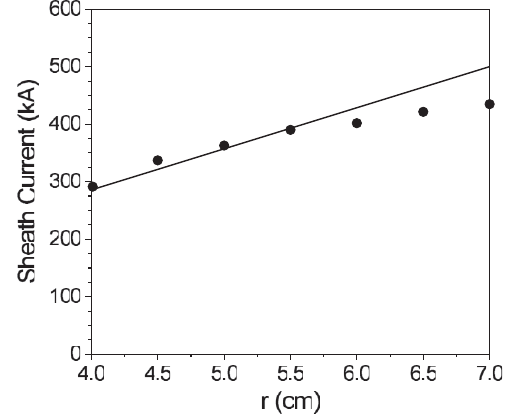
FIG. 5. Black data points indicate the temporally averaged electron sheath current as a function of radius from the baseline case. The solid line is the approximate sheath current as a function of radius from Eq. (5b) with I r 2 ¼ 7 cm.